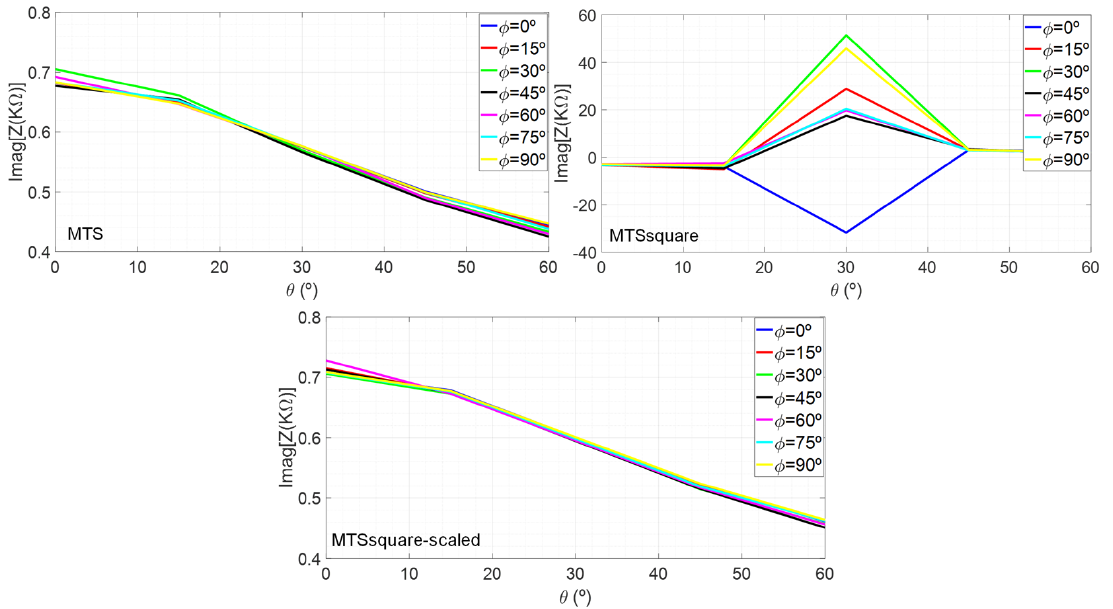
Figure 12. Imaginary part of the surface impedance at 24.125 GHz for the antennas under analysis. Tangential components of the electric field, Ex and Ey, in a plane located a short distance above the antenna (field at the antenna aperture) are obtained and analyzed for further insight into the antennas under analysis.